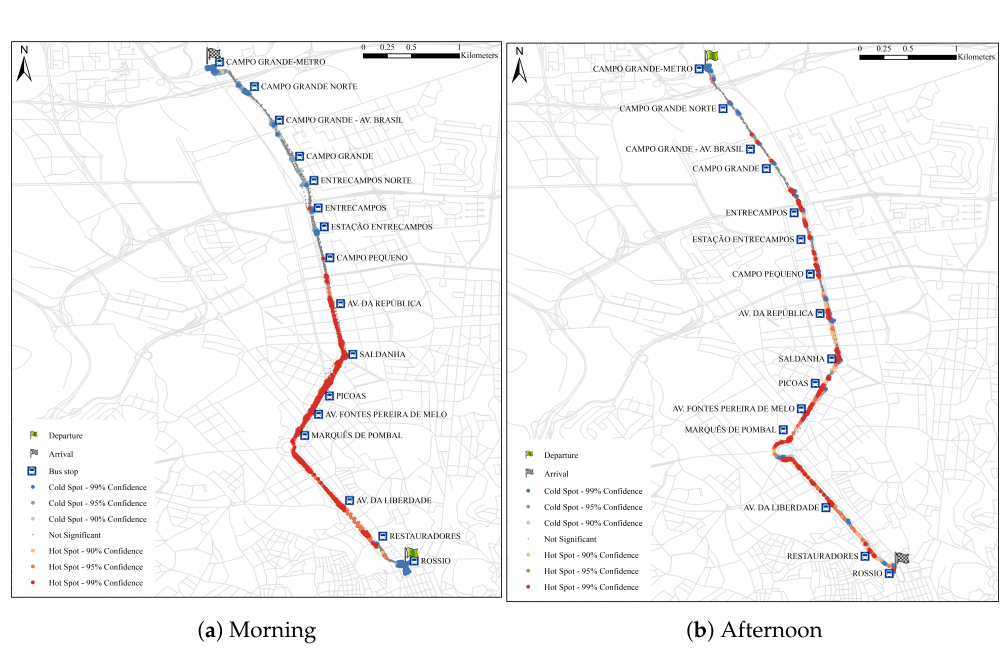
Figure 4. Bus CO 2